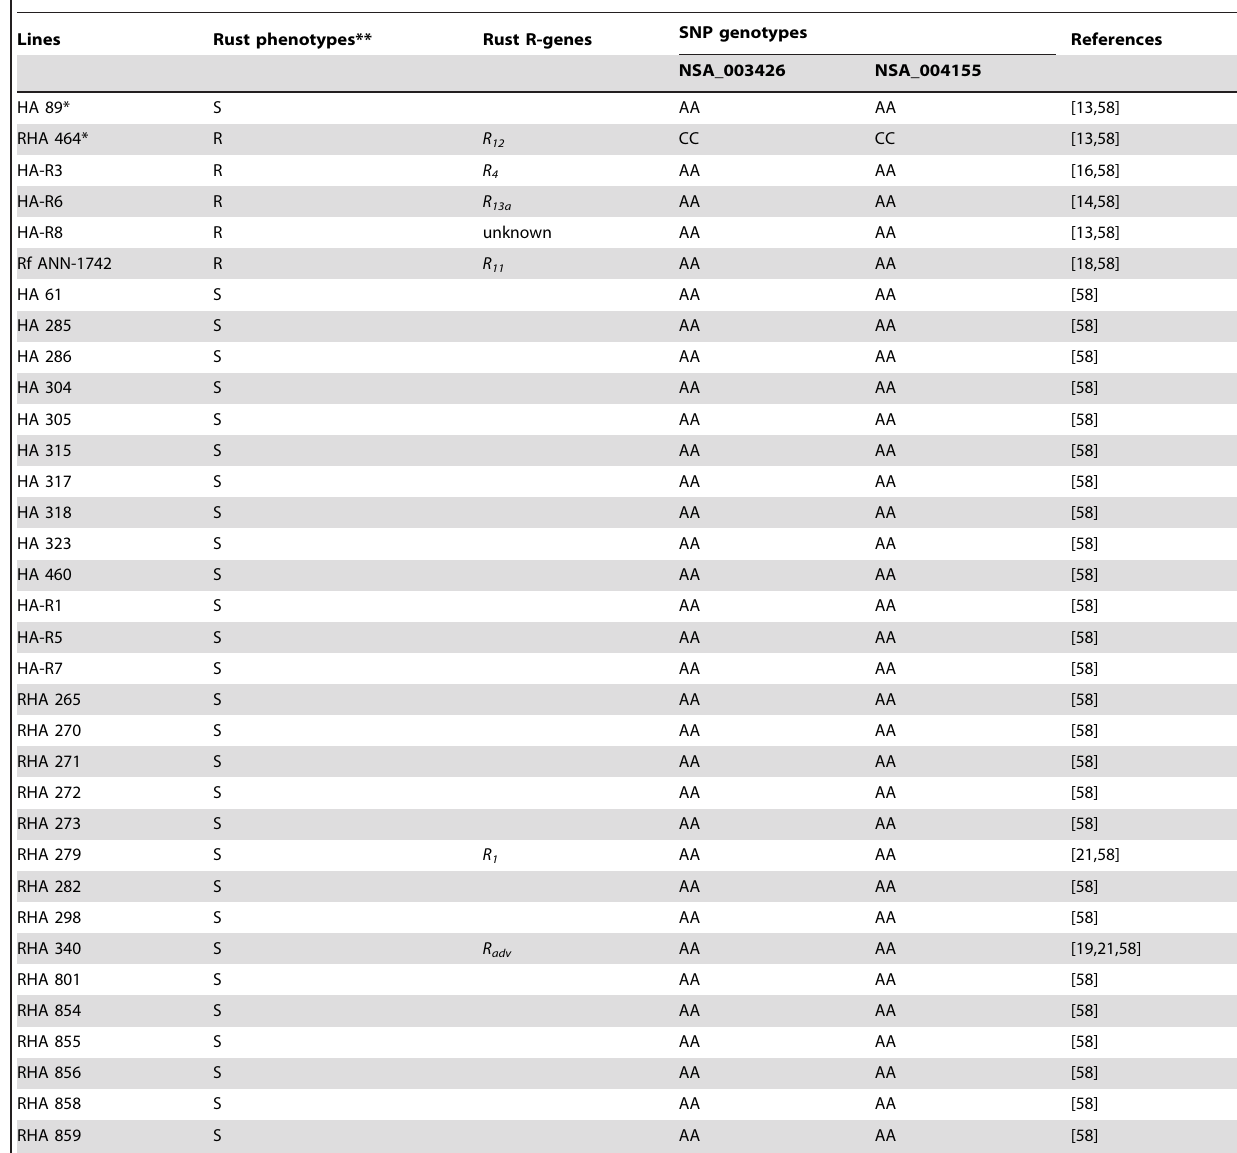
Table 4. A subset of rust phenotypes and SNP profiles of NSA_003426 and NSA_004155.